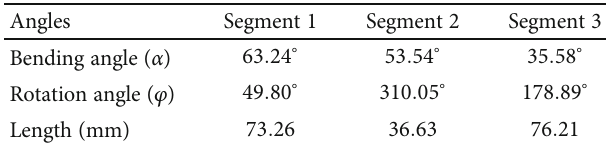
Figure 5: Con fi guration of the three-segment catheter with bending and rotation angles. Table 2: Three-segment continuum robot bending and rotation angles.